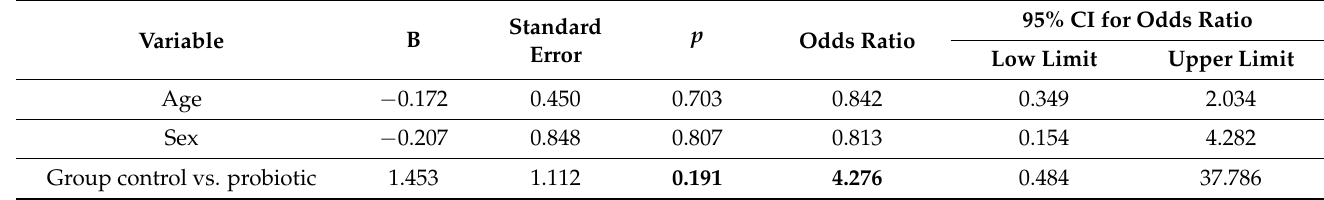
Table 6. Multivariate analysis of ∆ ICDAS 1–2 > 0; 12 months—baseline, n